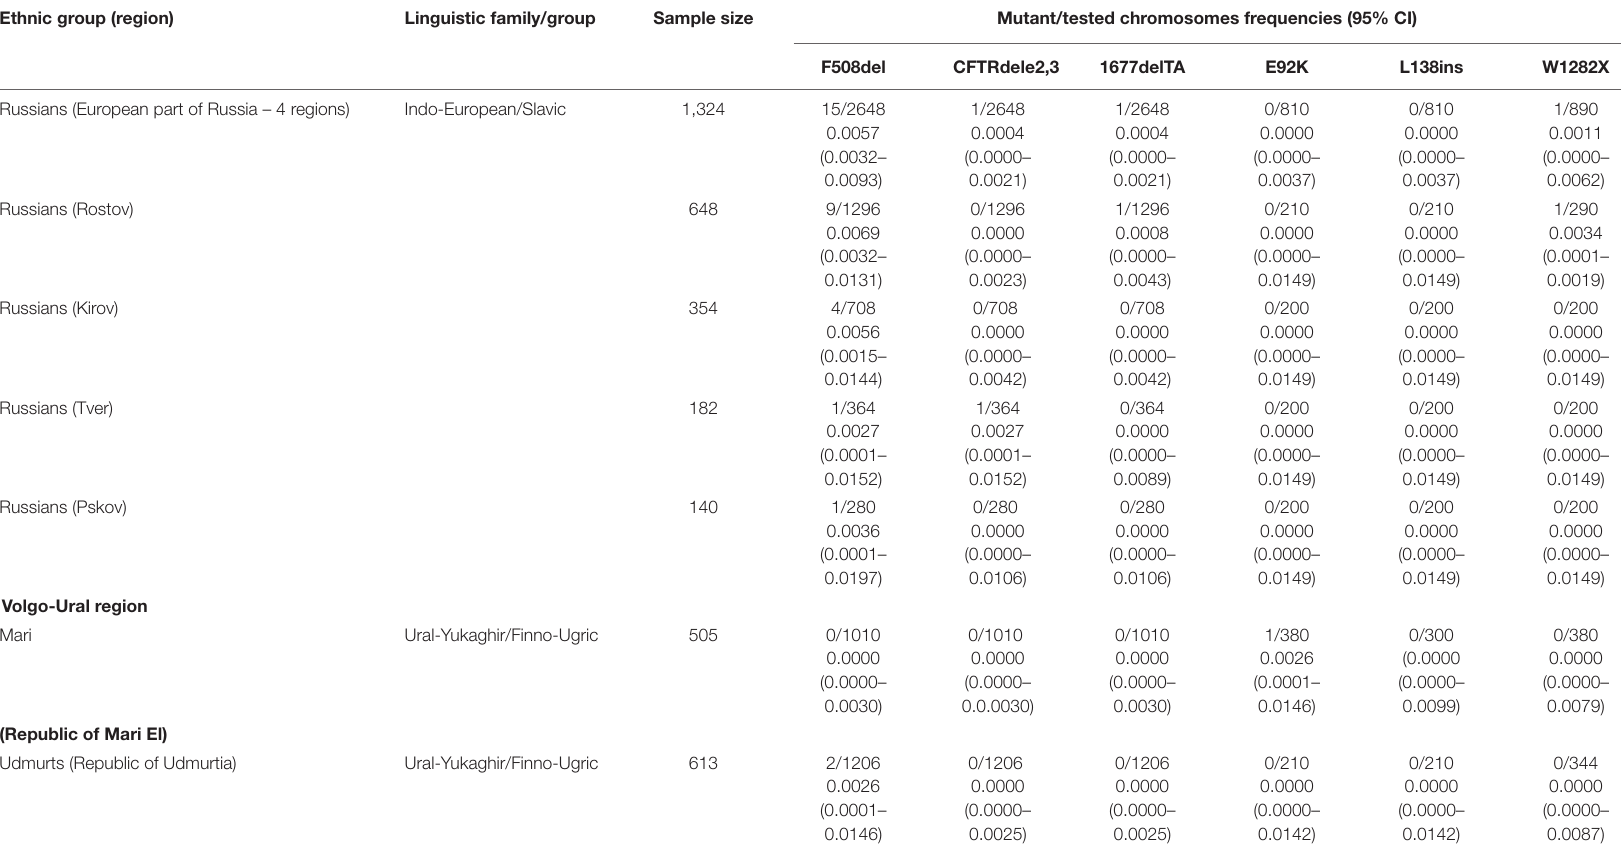
TABLE 1 | Allele frequencies of identified mutations in studied populations of European part of Russia (Eastern European, Volga-Ural and North Caucasus